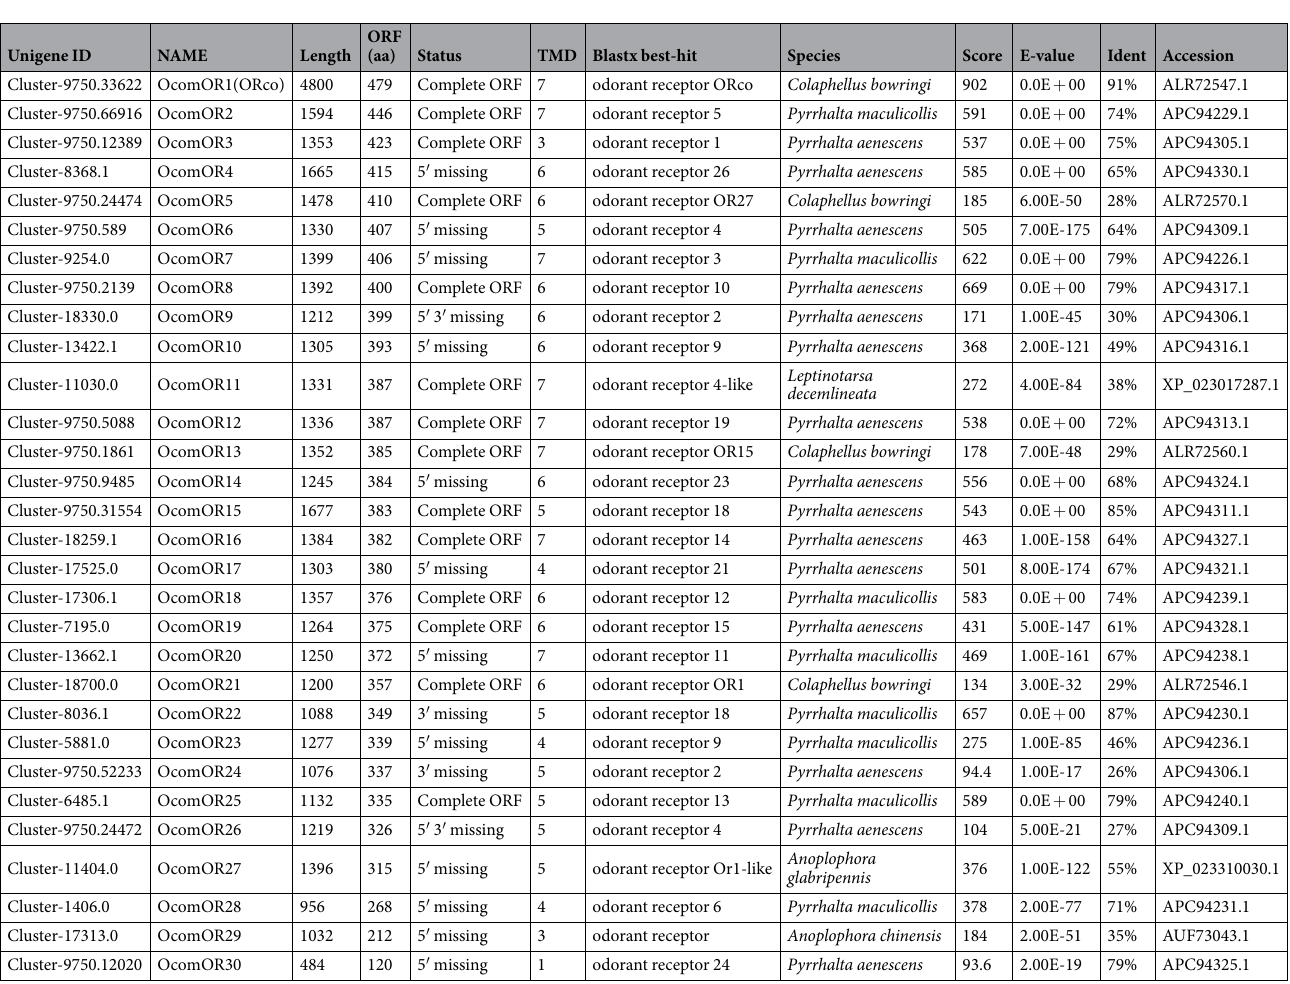
Table 3. The Blastx match of O . communa candidate odorant